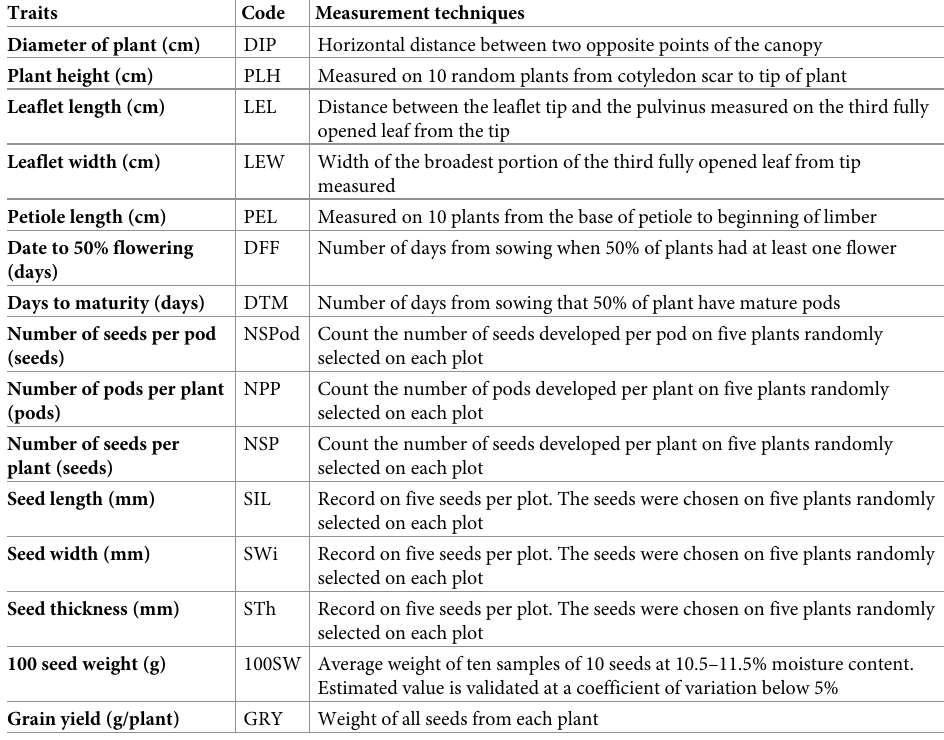
Table 2. Morphological traits and measurement techniques for phenotypic characterization of Kersting’s groundnut. Traits